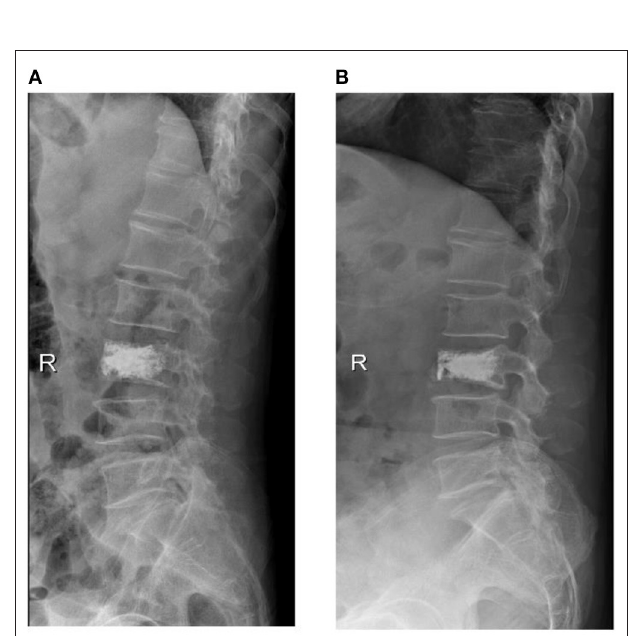
FIGURE 4 | Schematic diagram of vertebral body height restoration after percutaneous kyphoplasty (PKP). Separated cement mass (A,B) . Cement-contacted upper endplate with integrated cement mass (C,D) .